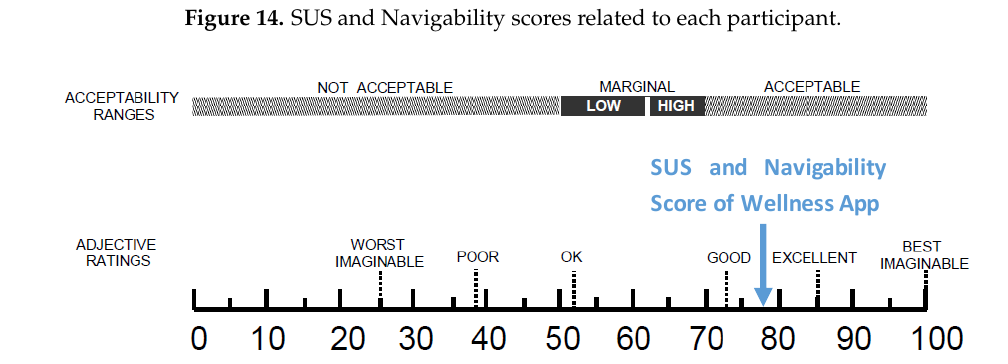
Figure 15. A comparison of the adjective ratings, acceptability scores, and school grading scales, in relation to the average SUS and Navigability